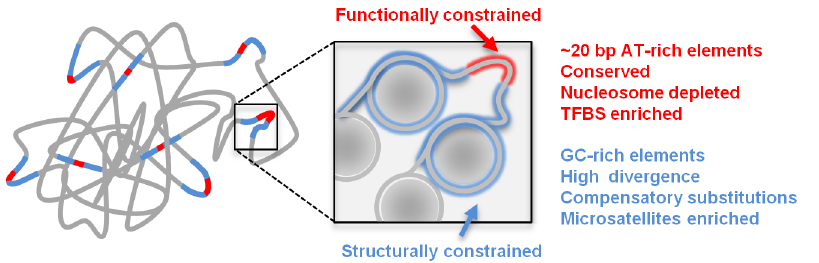
Figure 5. Schematic model of genome structure and function. Conserved elements (red) are surrounded by structural sequences (blue) which are packaged by nucleosomes (gray circles) and crucial for maintaining the physical structure associating the CEs into functioning